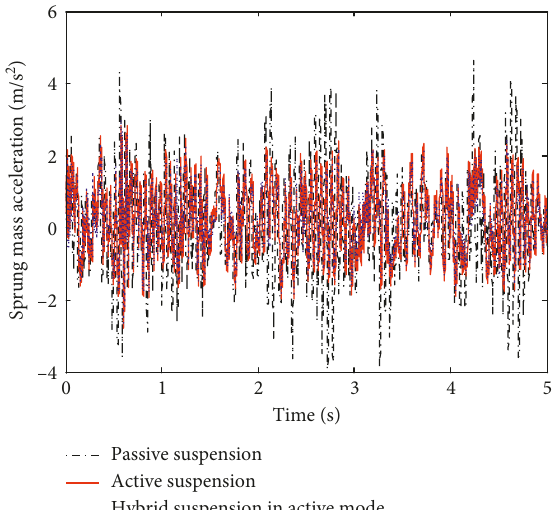
Figure 26: The dynamic responses of the sprung mass acceleration of the hybrid suspension in semiactive mode.